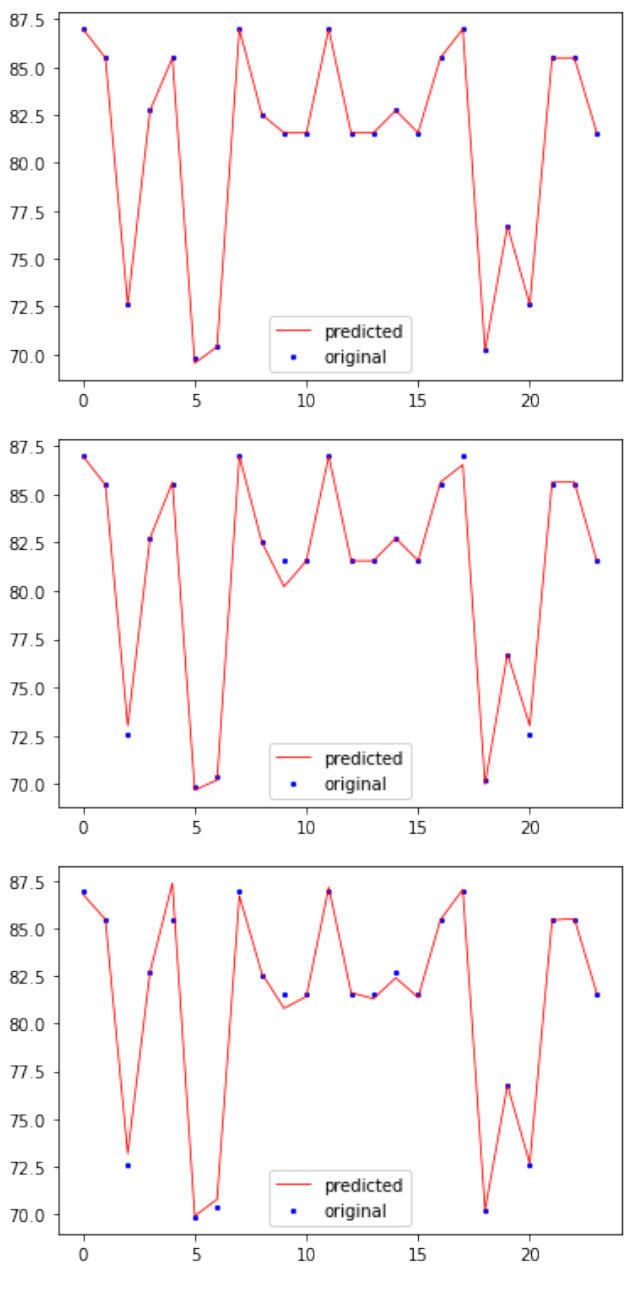
Figure 6. Models evaluation plots with Decision Tree sitting on top, Random Forest in the middle and XGBoost on the